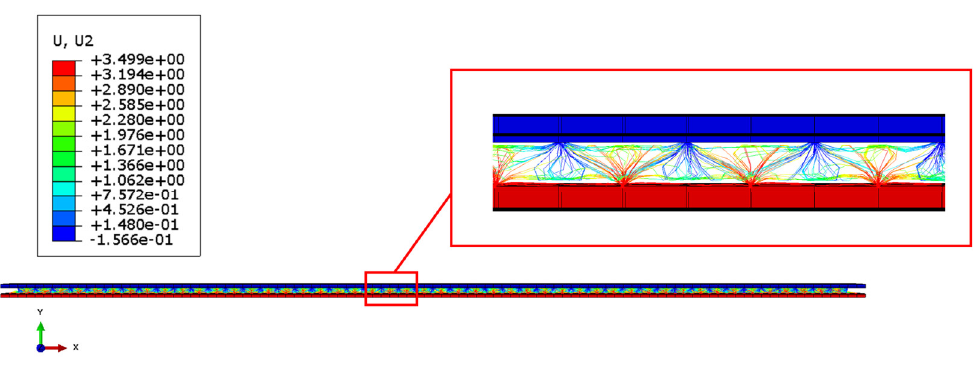
Figure 14. Deformed Shapes—out of plane displacements in mm.